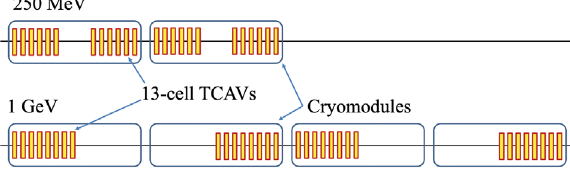
FIG. 2. The layout of TCAVs inside the cryomodules for the MaRIE linac. Two design options for TCBC at 250 MeV (above) and 1 GeV (below) are